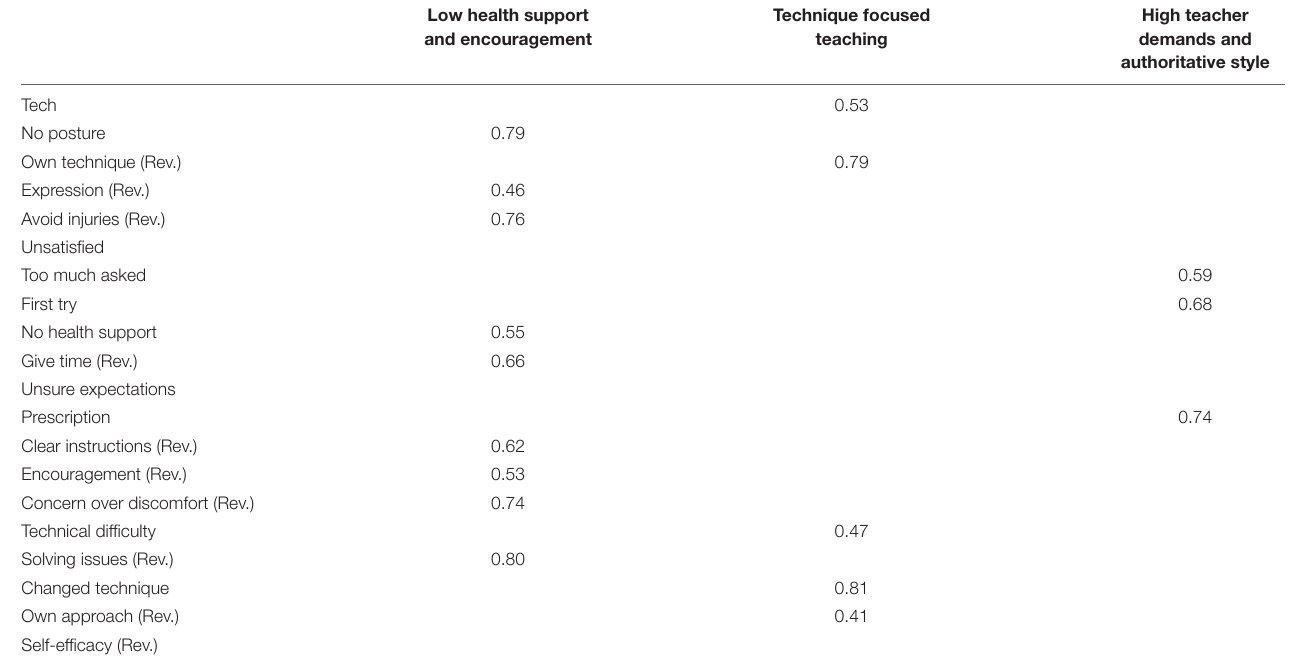
TABLE 4 | Factor loadings–EFA pattern matrix “music education”.